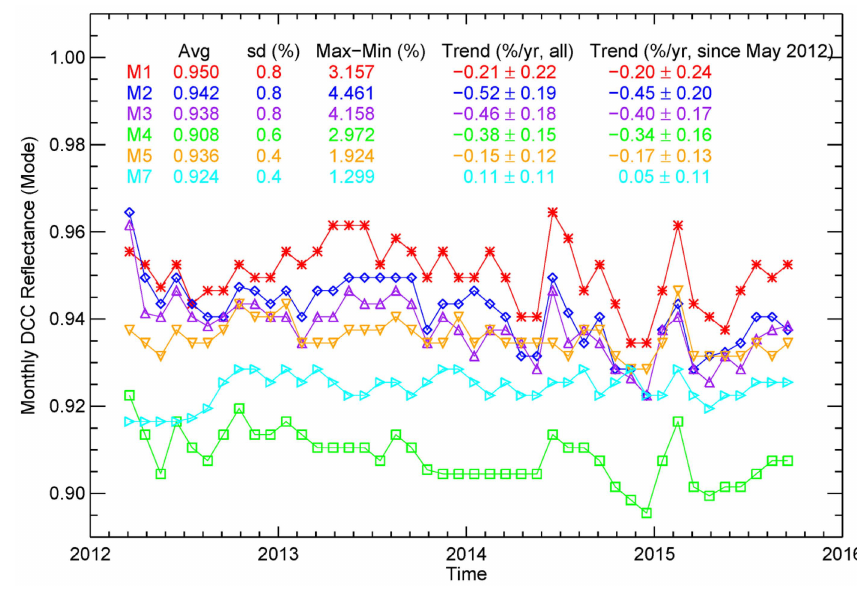
Figure 3. Monthly DCC mode time series for bands M1–M5 and M7 (March 2012–September 2015).